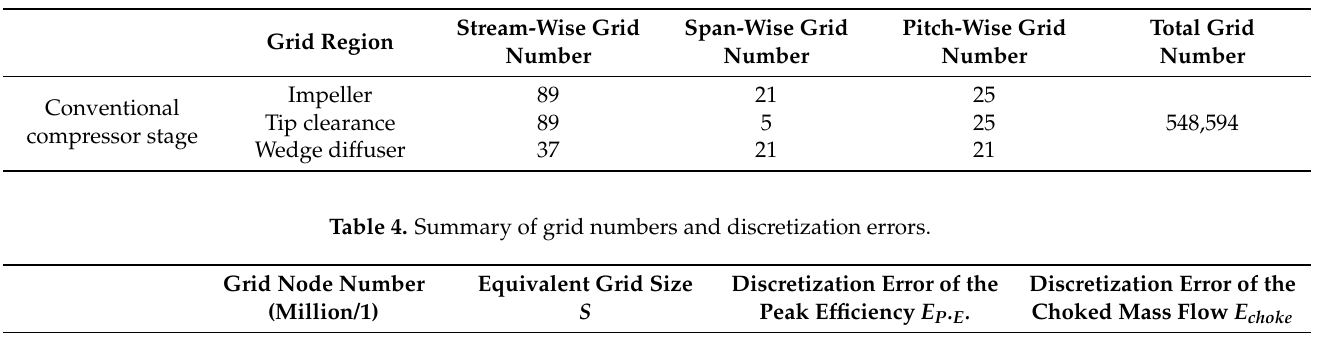
Figure 8. Comparison of the conventional compressor experimental results and calculations for different meshes. Table 3. Grid node distribution of the coarsest mesh.